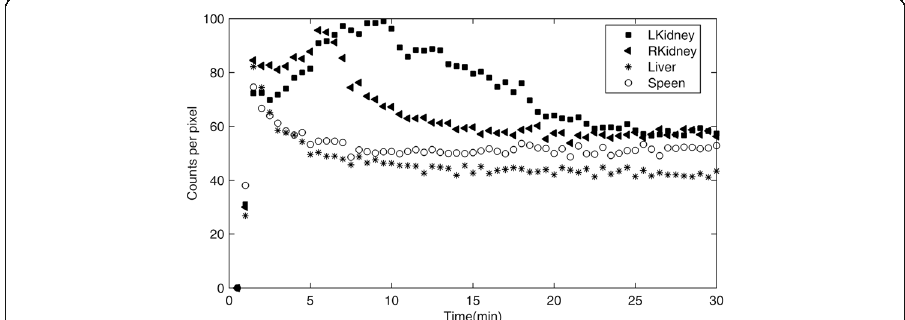
Fig. 5 Time-activity curves showing radiotracer uptake in the kidneys, liver, and spleen. The data were obtained from a 30-min dynamic planar